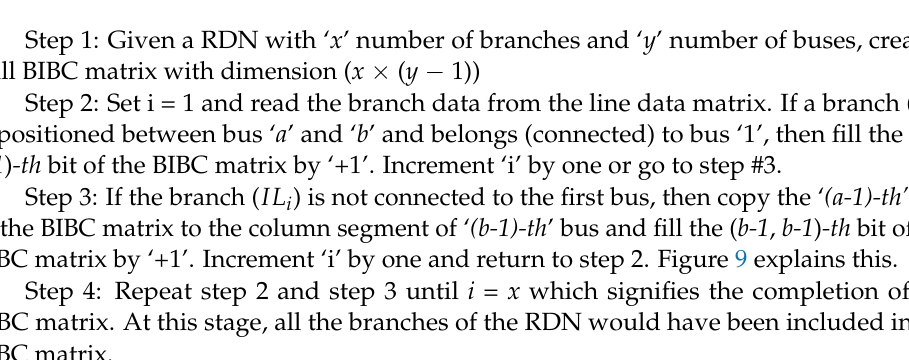
Figure 8. Procedural steps for the formation of the BIBC matrix.